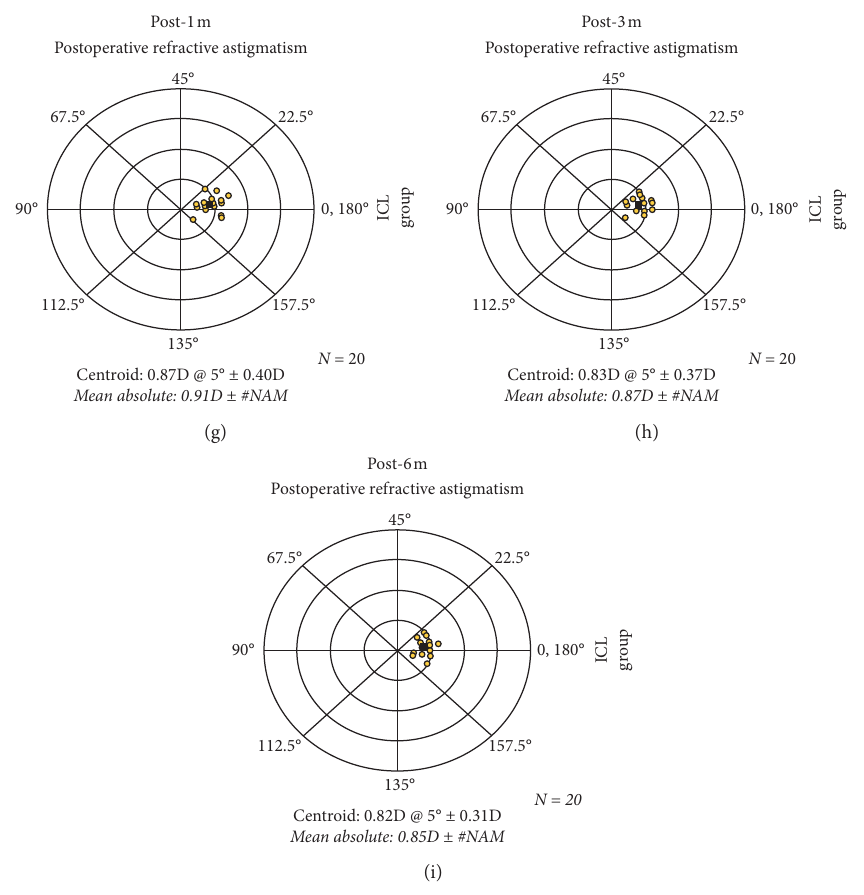
Figure 5: Double-angle plot vector analysis of postoperative residual astigmatism distribution in three groups at 1, 3, and 6 months (the figure shows the LenSx +ICL group, TICL group, and ICL group, respectively, each ring � 1.00 D). (a) Post-1 m postoperative refractive astigmatism. (b) Post-3m postoperative refractive astigmatism. (c) Post-6m postoperative refractive astigmatism. (d) Post-1m postop- erative refractive astigmatism. (e) Post-3m postoperative refractive astigmatism. (f) Post-6 m postoperative refractive astigmatism.